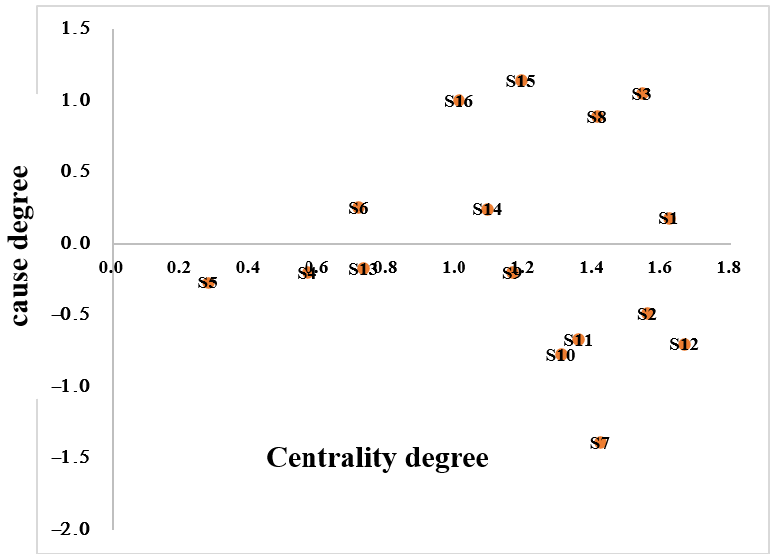
Figure 5. Centrality-Cause degree distribution of brittleness index factors in lean–green manufacturing systems in the context of Industry 4.0.